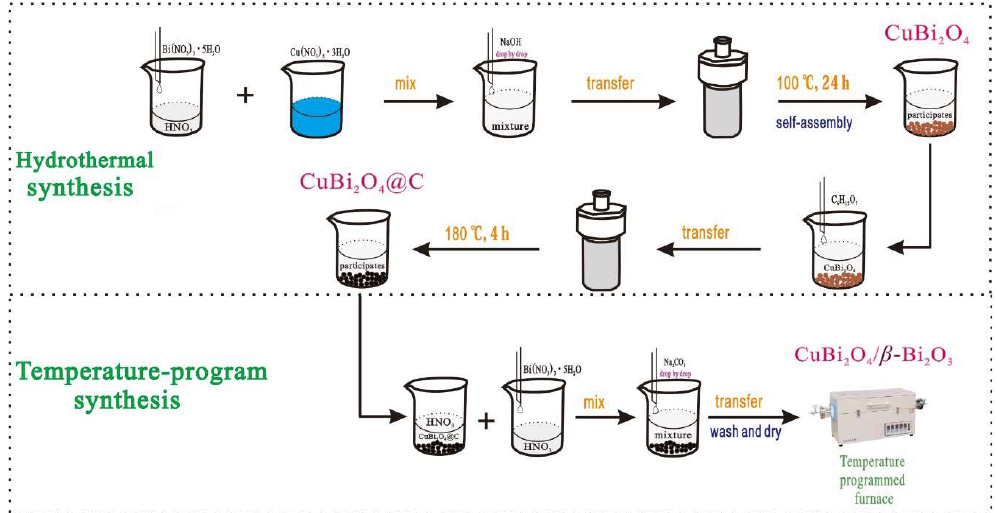
Figure 1. The detailed synthesis pathway of CuBi 2 O 4 / β -Bi 2 O 3 .